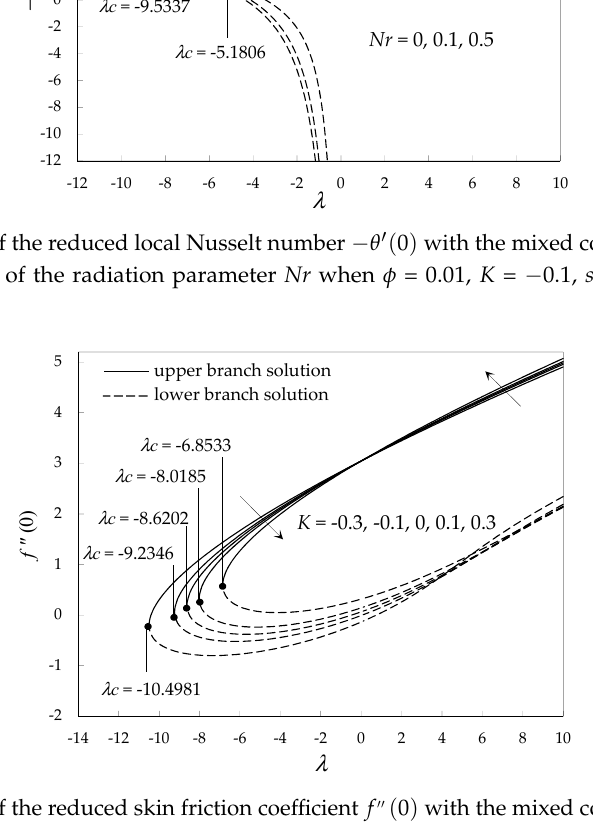
Figure 5. Variation of the reduced local Nusselt number −𝜃′(0) with the mixed convection parameter 𝜆 for several values of the radiation parameter Nr when 𝜙 = 0.01, K = − 0.1, s = 1 and c = − 1 for Cu- water nanofluid.